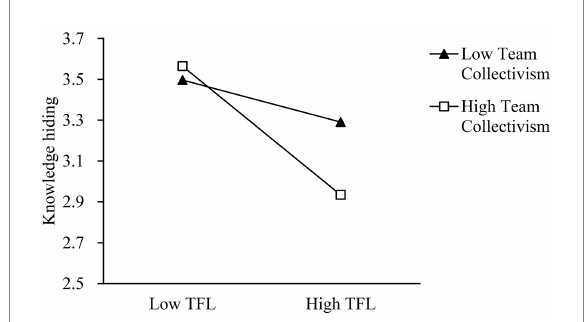
FIGURE 2 Team collectivism as a moderator of the relationship between TFL and knowledge hiding.